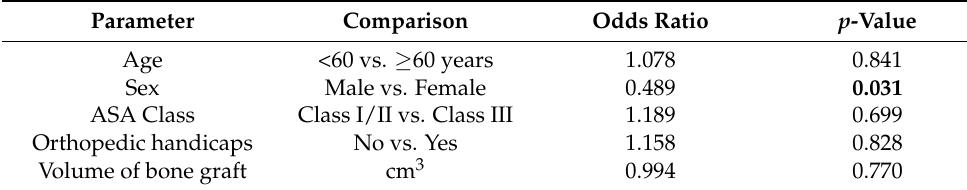
Table 2. Regression analysis performed for evaluation of gait